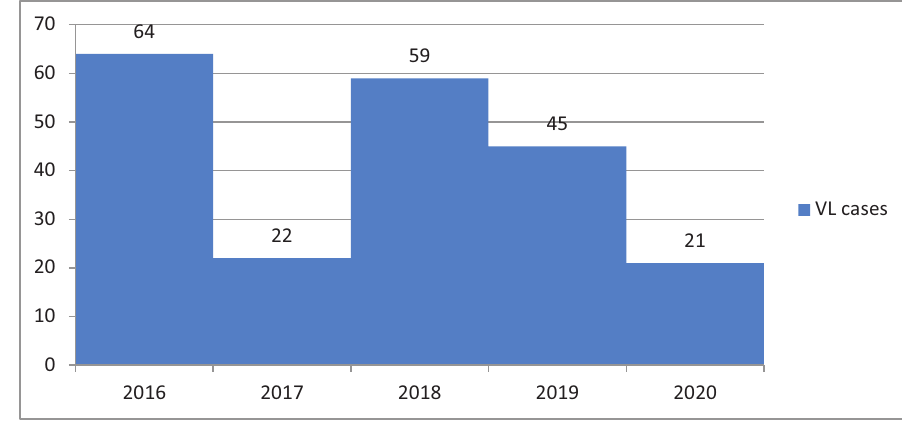
Figure 1 : Histogram showing the trend in VL over the 2016–2020